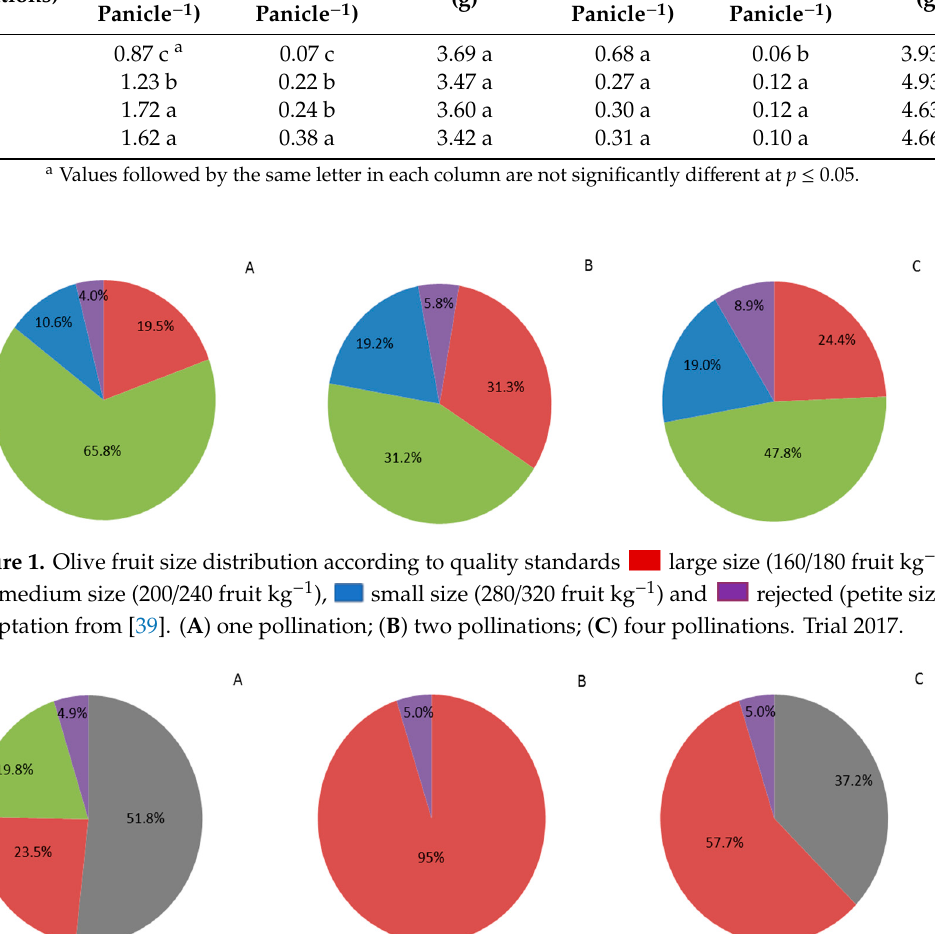
Figure 2. Olive fruit size distribution according to quality standards large size (160/180 fruit kg − 1 ), medium size (200/240 fruit kg − 1 ), small size (280/320 fruit kg − 1 ) and rejected (petite size). Adaptation from [39]. ( A ) one pollination; ( B ) two pollinations; ( C ) four pollinations. Trial 2017.